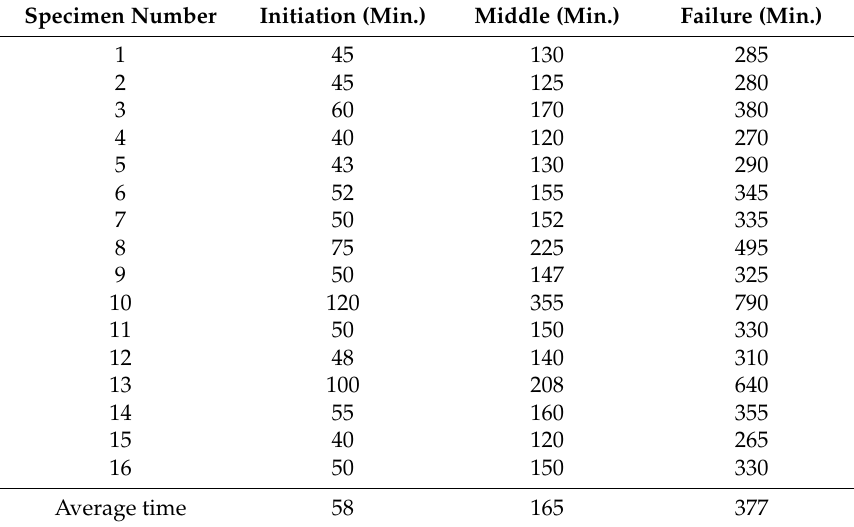
Table 5. Time to failure of tree model